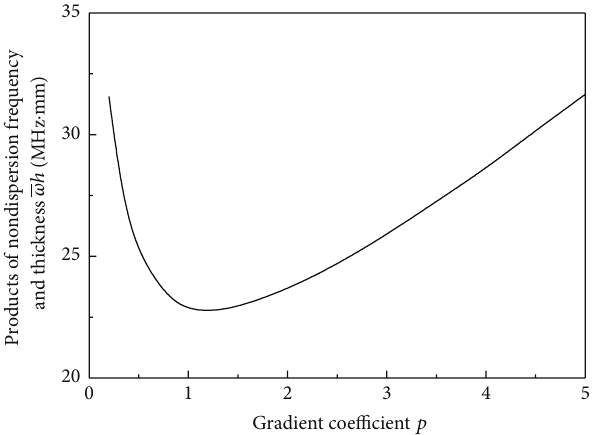
Figure 5: The relation between gradient coefficient and the nondis- persion frequencies of Lamb waves in the first mode.